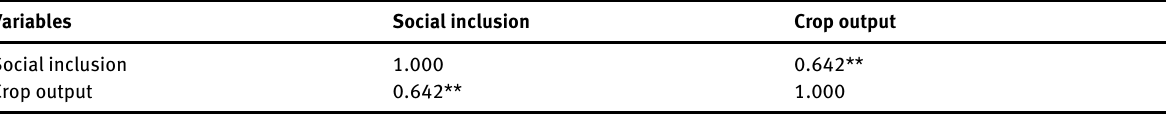
Table 4: Estimation of influence of social inclusion on crop output Variables